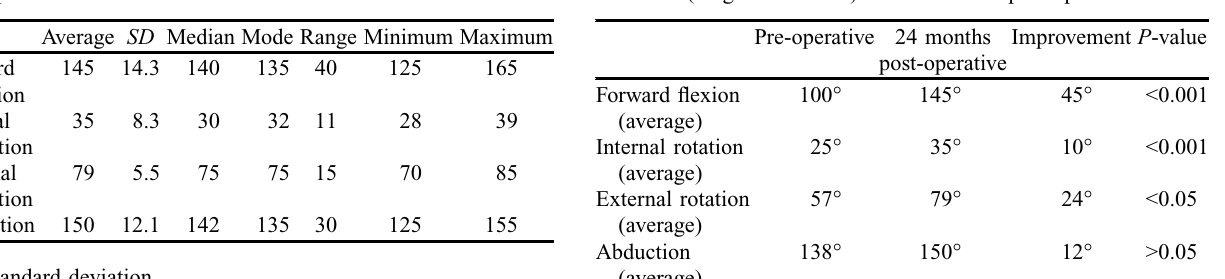
Table 5. Comparison between pre-operative primary outcome measures (ranges of motion) and 24 months